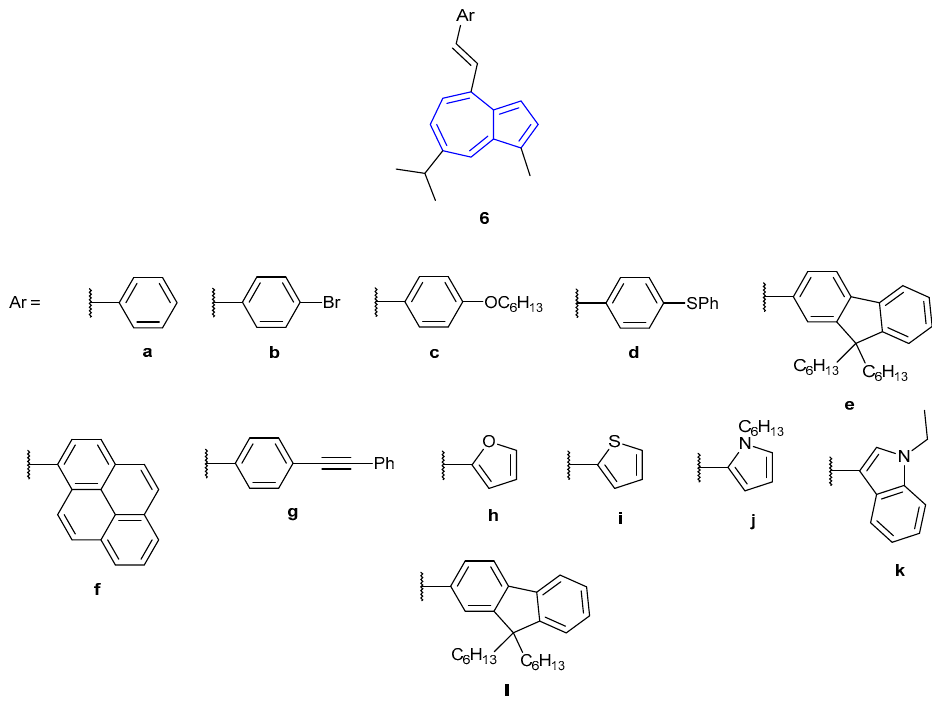
Figure 6. 4-Styrylguaiazulene derivates synthesised by Belfield et al. in 2015 [51] .